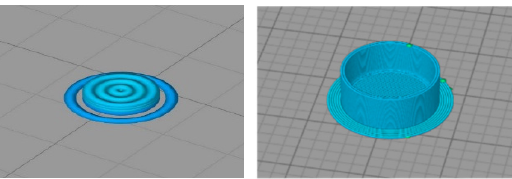
Figure 1. Software images showing the design of the PLA discs and the well ‐ shaped samples.